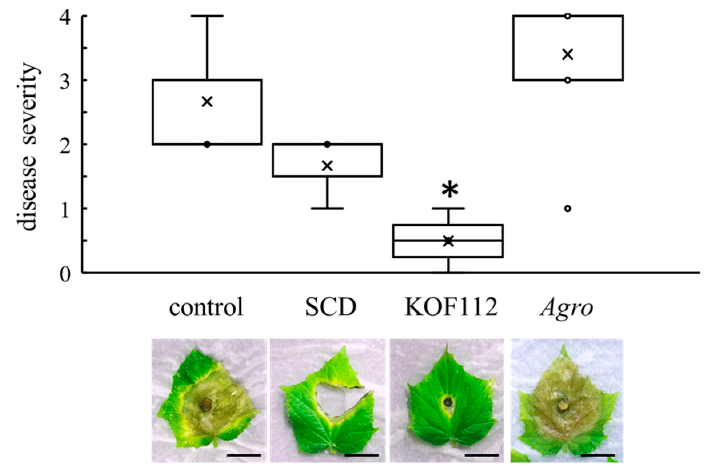
Figure 6. Suppression of cucumber gray mold by KOF112. Disease severity was evaluated as de- scribed in Materials and Methods. Crosses (×) indicate means of two independent experiments with three true leaves. * p < 0.05 compared with control and SCD. The representative symptom of cucum- ber gray mold on true leaves is shown below the graph. Control, untreated. SCD, treated with 10% SCD. KOF112, treated with 1 × 10 8 cfu/mL KOF112. Agro , treated with 1 × 10 8 cfu/mL Agrobacterium sp. isolate CHB3 used as control isolate with no antifungal activity. Bar, 2 cm.